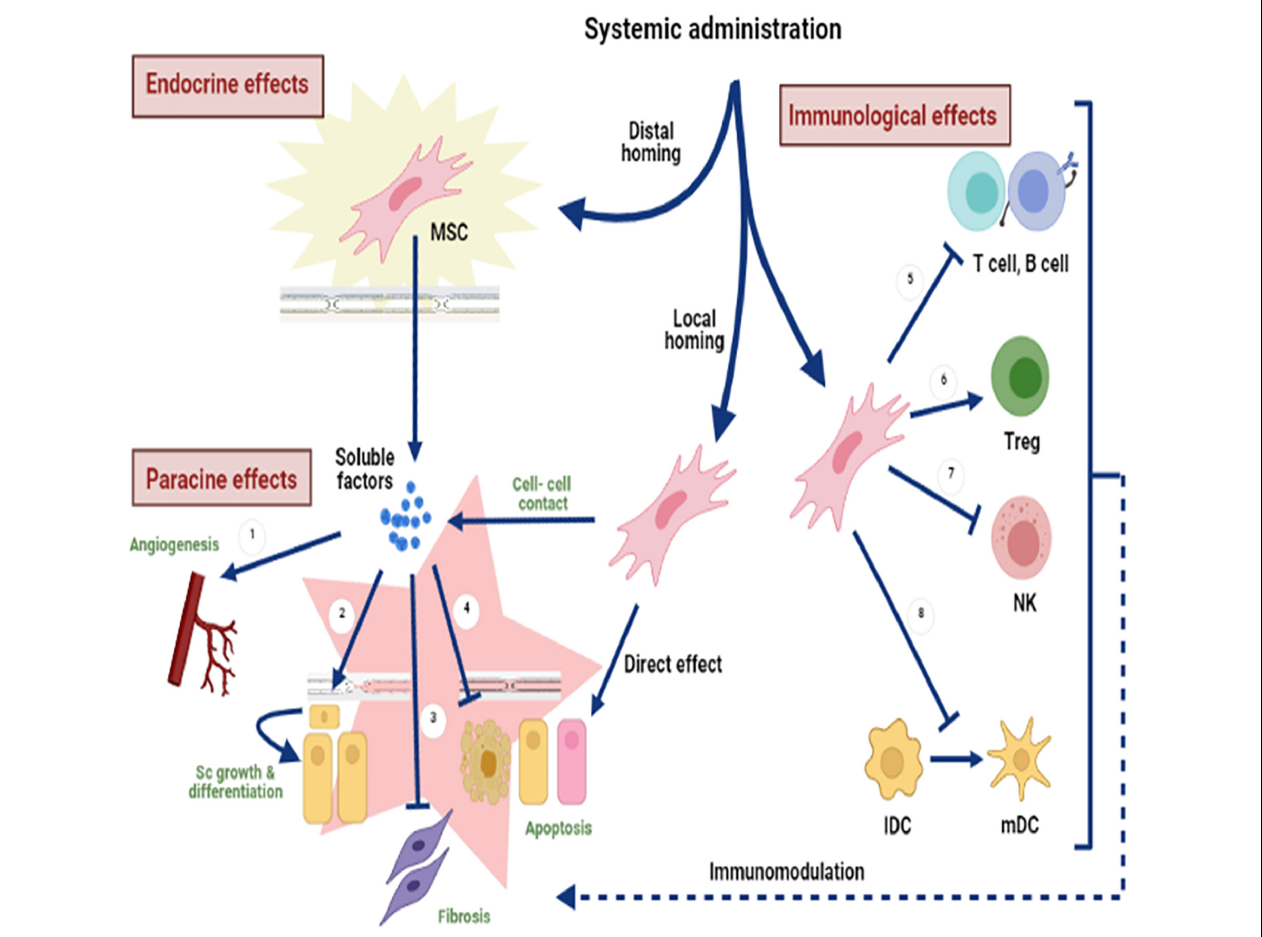
FIGURE 3 | Fundamental mechanisms of MSC-based therapy. These mechanisms differ in their repair activity, depending on various local microenvironments where MSCs can adjust their therapeutic effects accordingly. The systemic administration of MSCs can activate distal (endocrine) or local (paracrine) effects that include cell-mediated actions, which can take different forms, including (1) stimulation of angiogenesis, (2) stem cell growth and differentiation, (3) fibrosis inhibition, (4) apoptosis inhibition, (5) T- and B-cell suppression, (6) initiation of Treg differentiation, (7) NK cell inhibition, and (8) dendritic cell (DC) maturation